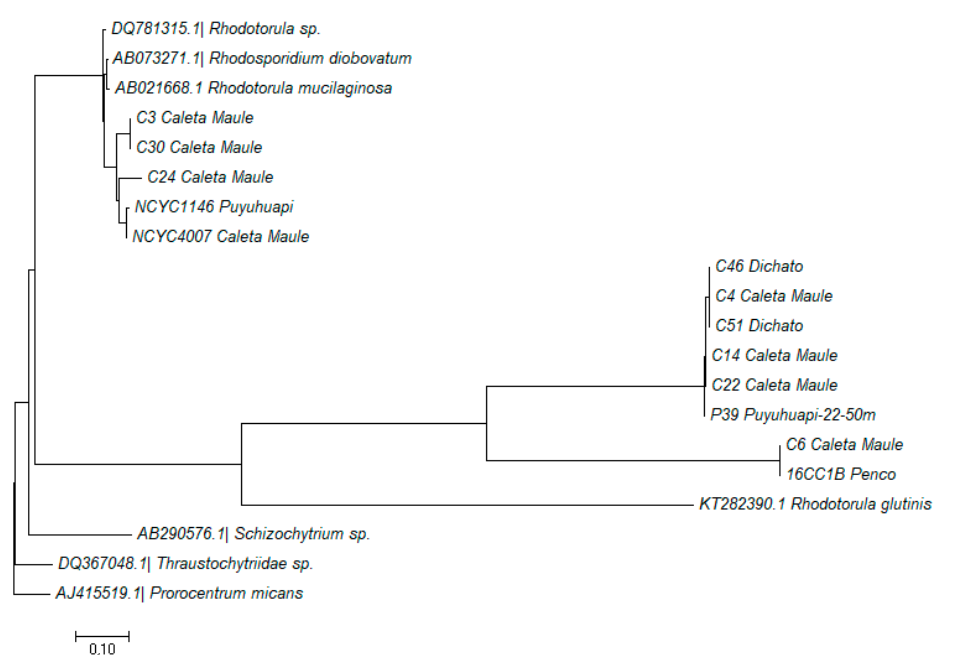
Figure 1. Location the NCYC1146 strain on the phylogenetic tree, based on the ribosomal gene 18s rRNA sequence, compared to the marine fungoides sequences described by Pino et al. [9]. To carry out the comparison, the species Rhodotorula sp., Rhodotorula mucilaginosa , Rhodotorula glutinis , Rhodosporidium diobovatum , Schizochytrium sp. and Thraustochytriidae sp. were used as representatives for the genus Rhodotorula , Rhodosporidium , Schizochytrium and Thraustochytrium . Prorocentrum micans was used as an outgroup. The tree was constructed by the Neighbor-joining (NJ) method and the MEGA 6 program. Table 1. Kinetic growth parameters of the NCYC 4007 and NCYC 1146 strains obtained by the tested culture media at three different temperatures (15, 21 and 31 ◦ C). Total biomass production in dry weight (B), maximum growth speed ( µ maximum) and duplication time